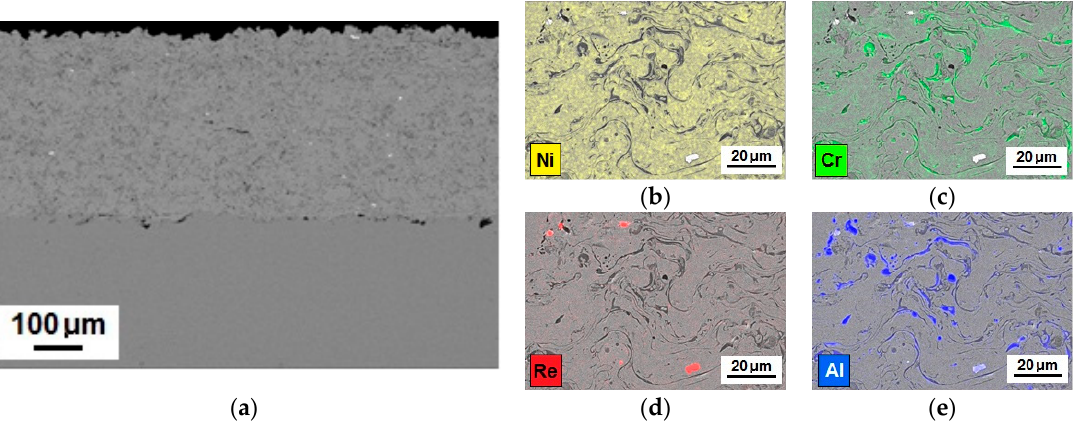
Figure 8. SEM micrograph ( a ) and EDX surface distribution of elements (Ni, Cr, Re, Al) analysis ( b – e ) of plasma-sprayed NiCrRe-Al 2 O 3 coating deposited on 16Mo3 steel substrate.